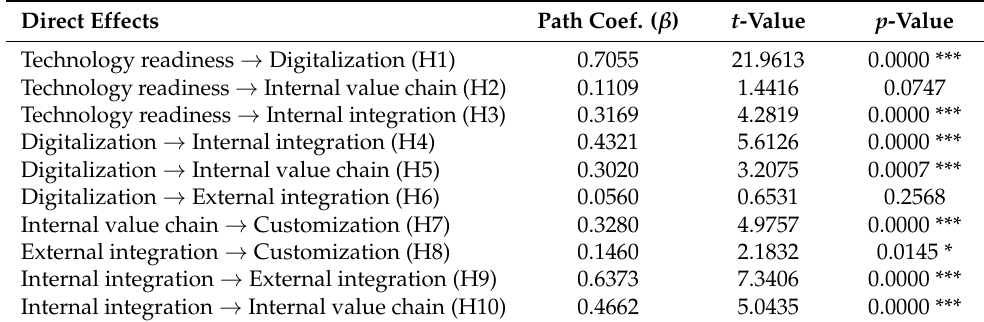
Table 6. The evaluation of